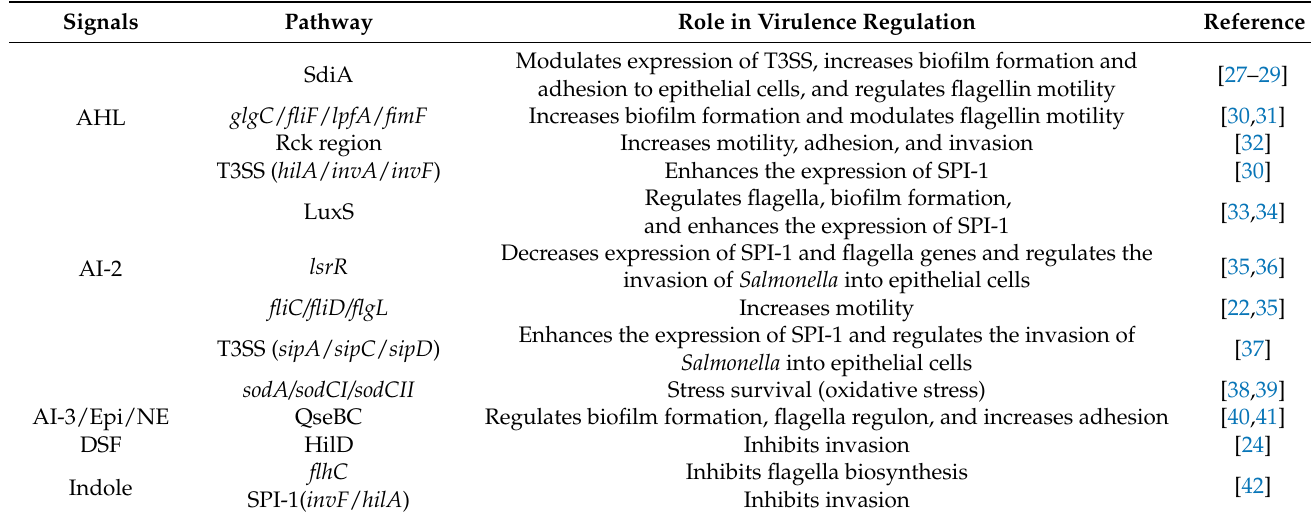
Table 1. Role of various genes in QS regulation of Salmonella